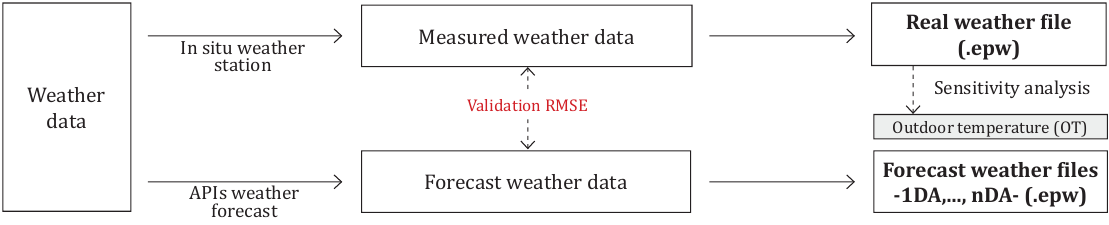
Figure 2. Weather data processing